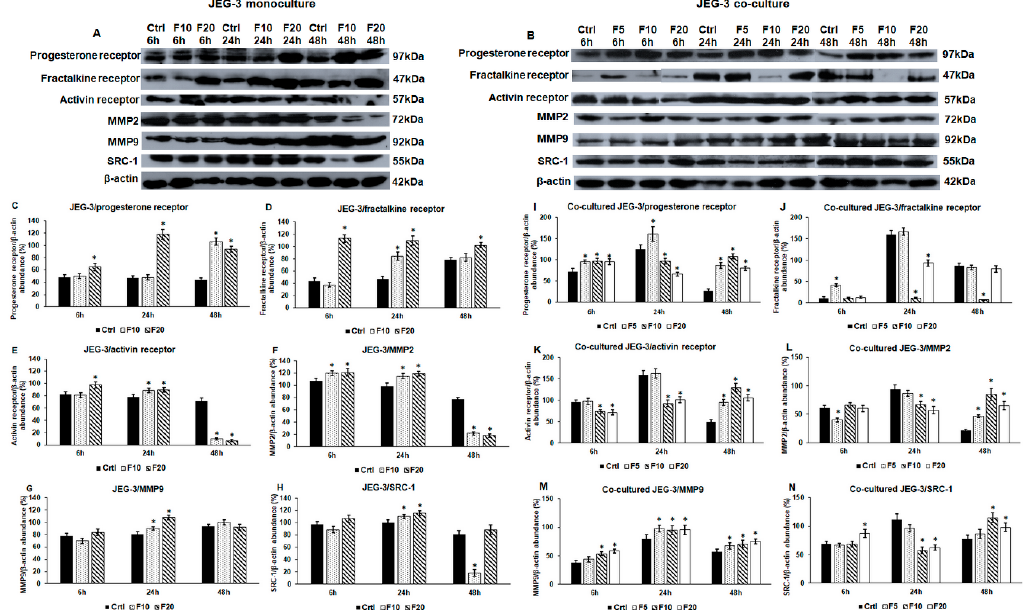
Figure 4. Western blot analyses of implantation-related proteins in fractalkine treated mono- ( A ) and co-cultured ( B ) JEG-3 cells. JEG-3 cells were collected and pelleted after fractalkine